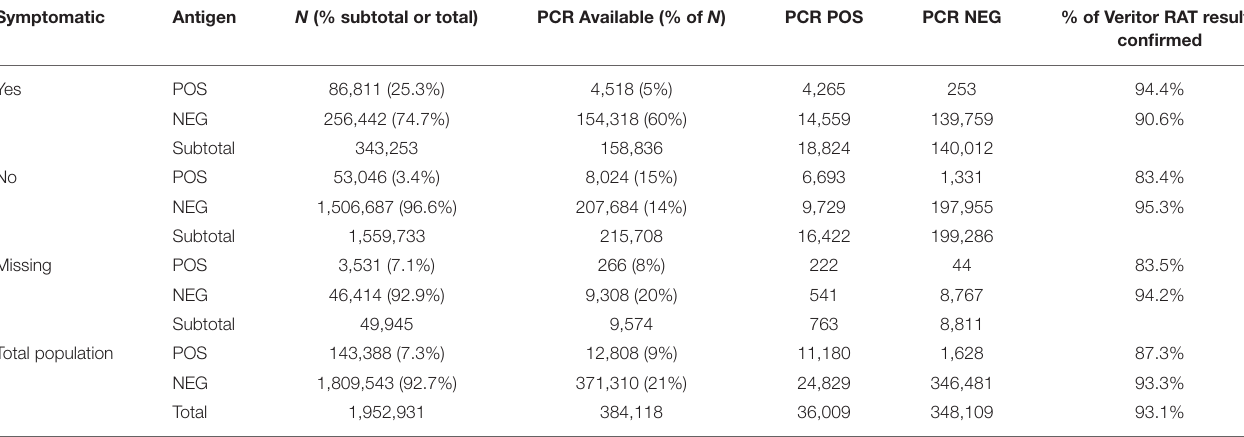
TABLE 1 | Percent agreement for specimens with a reflex RT-PCR test after antigen test for SARS-CoV-2.